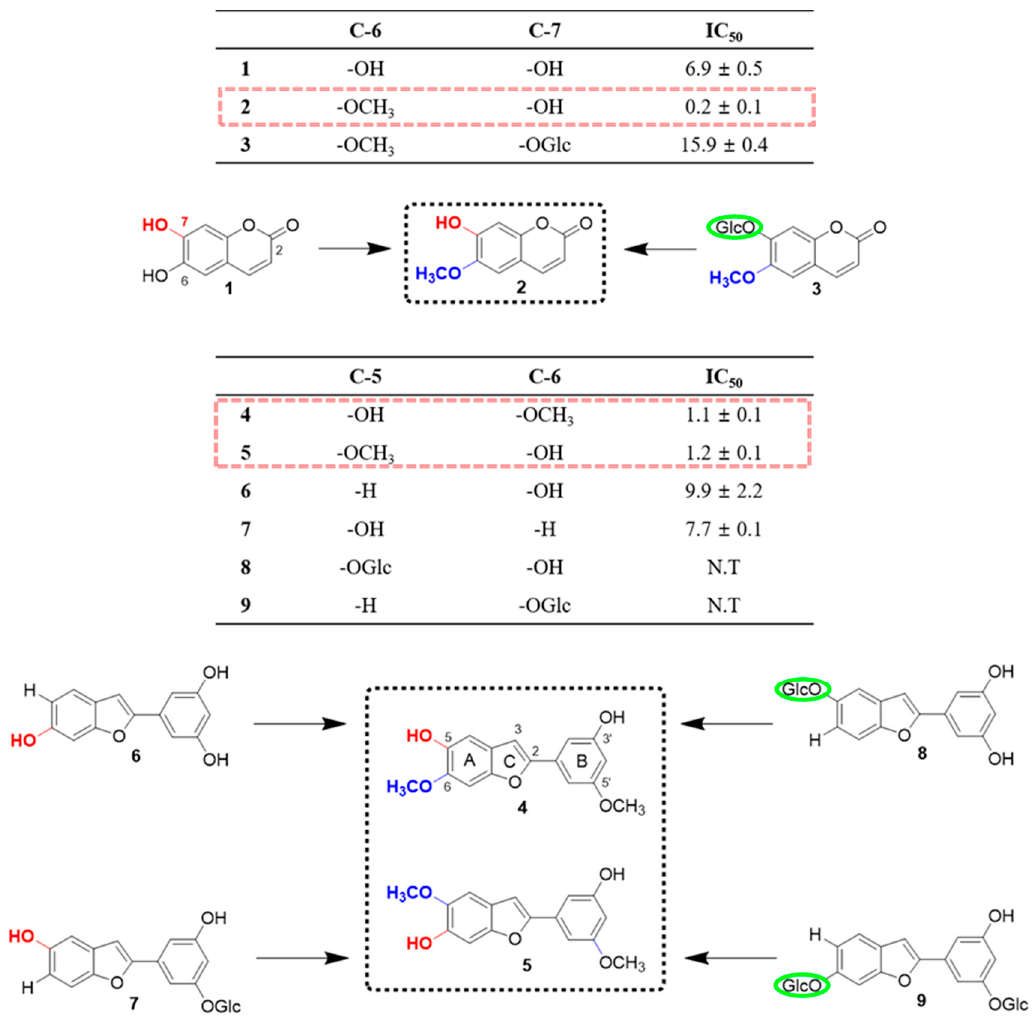
Figure 3. Identification of the structure-activity relationship based on the soluble epoxide hydrolase (she) inhibitory effects of compounds isolated from the leaves of M. alba . Table 1. Inhibitory effects of isolated compounds 1 ‒ 9.